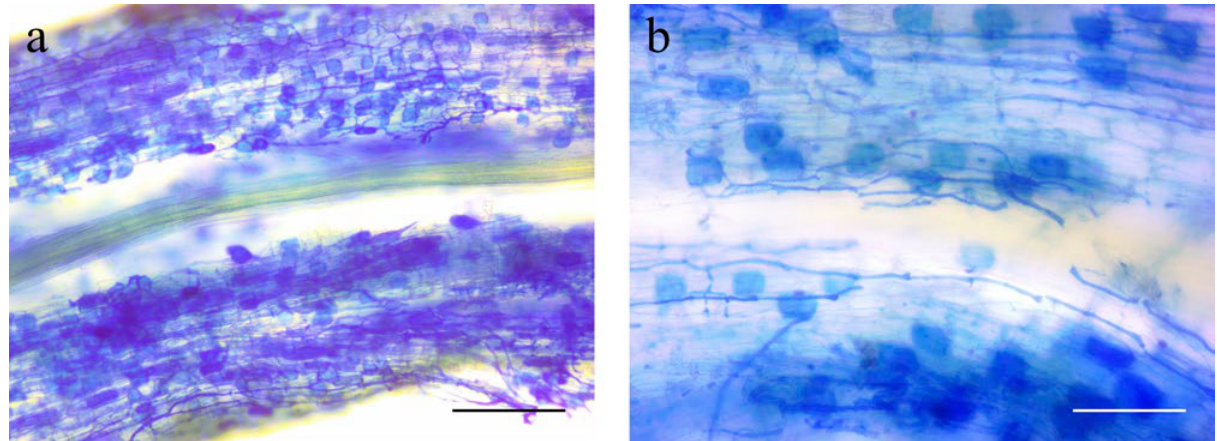
Figure 2. Micrograph showing AMF colonizing Olea europaea cv. Frantoio (olive) roots collected in the field and stained using methyl-blue (a-b). Scale bars: a = 500 μm; b = 200